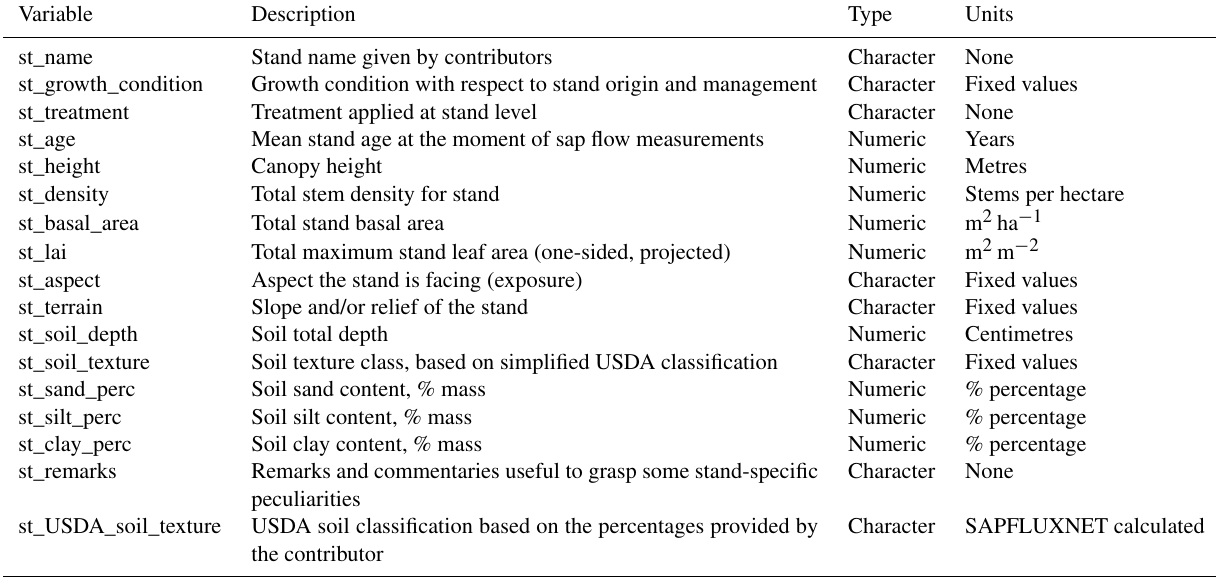
Table A3. Description of stand metadata variables in SAPFLUXNET datasets.